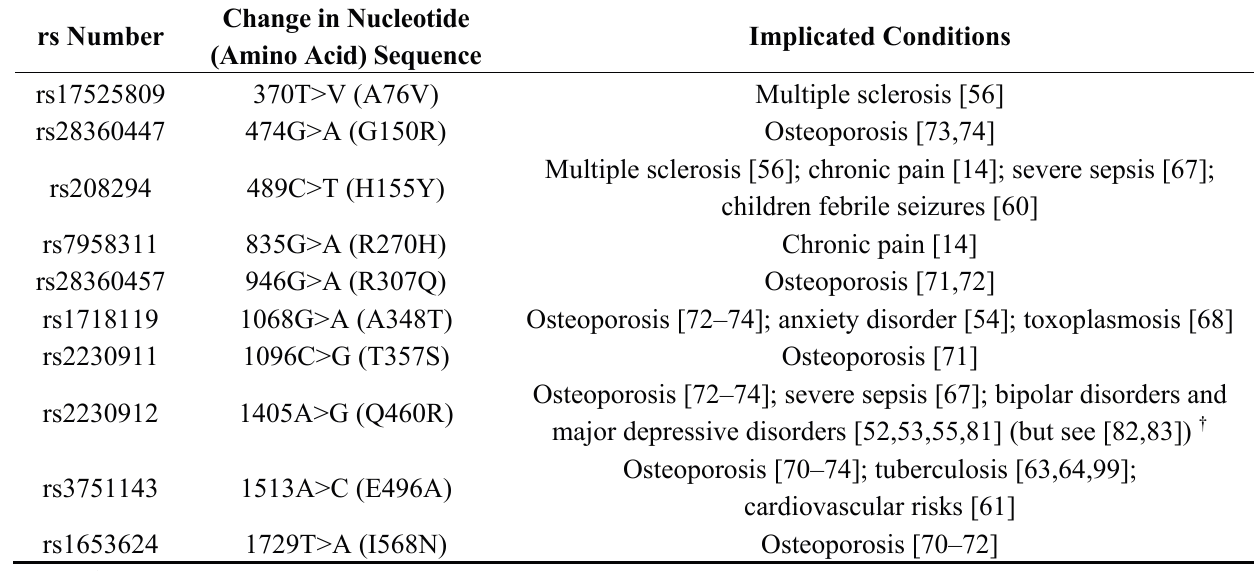
Table 1. Disease-associated non-synonymous single nucleotide polymorphisms (NS-SNPs) in the P2RX7